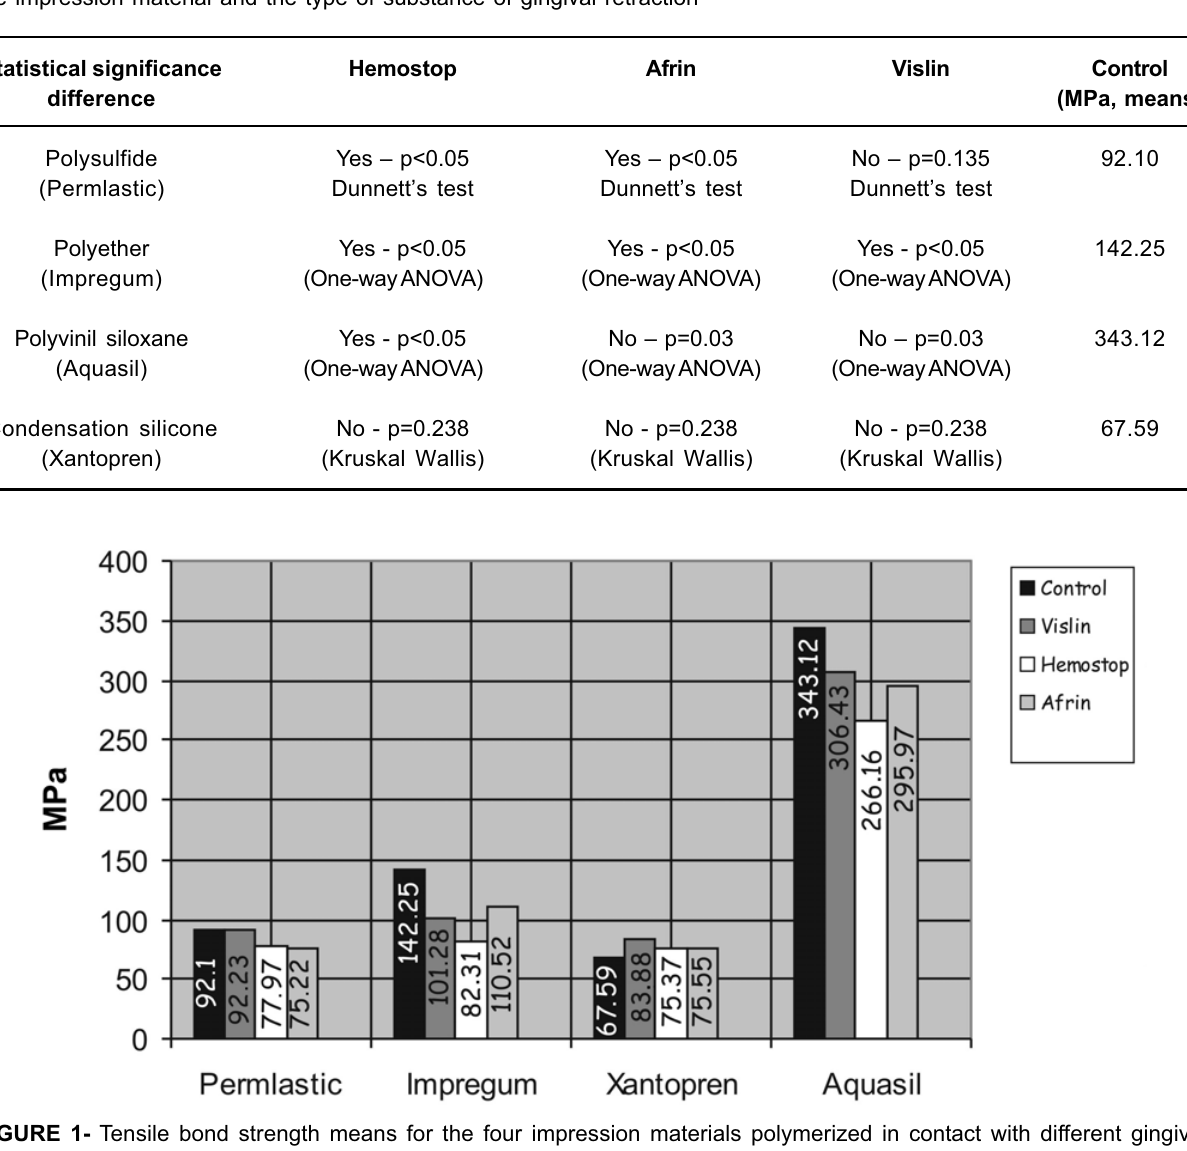
TABLE 1- Statistically significant differences and the type of statistical test used in agreement with the interaction between the impression material and the type of substance of gingival retraction